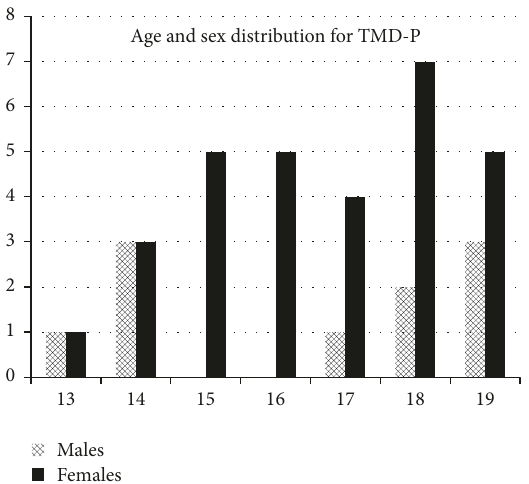
Figure3:Theageandsexdistributioninthecasegroupispresented. Females are highly overrepresented from the age of 15.